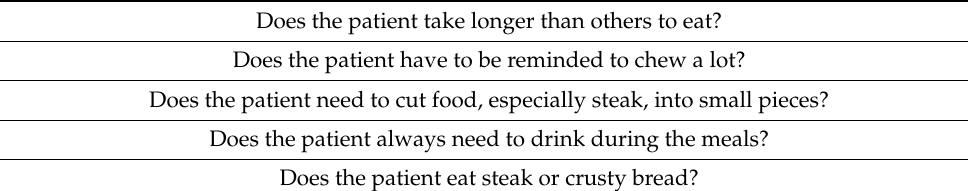
Table 6. Useful questions to ask patients with EoE (Adapted from Muir et al., 2019) [59]. Does the patient take longer than others to eat? Does the patient have to be reminded to chew a